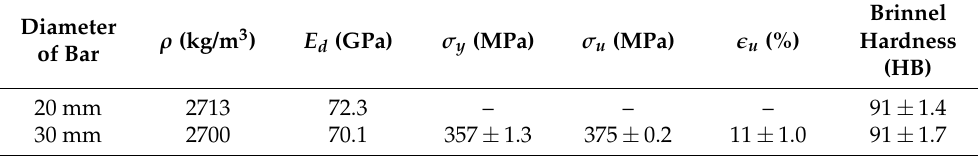
Table 2. Physical and mechanical properties of the investigated EN-AW6082 aluminum